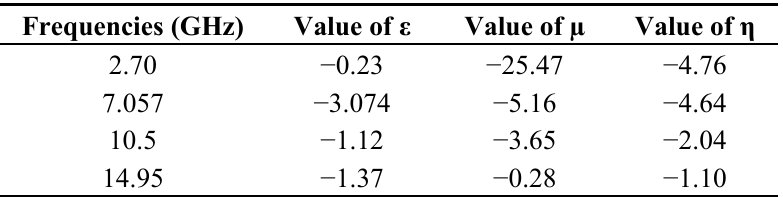
Table 5. Real values of ε, µ and η in the desired resonance frequency bands for the 2 × 2 array of the unit structure.